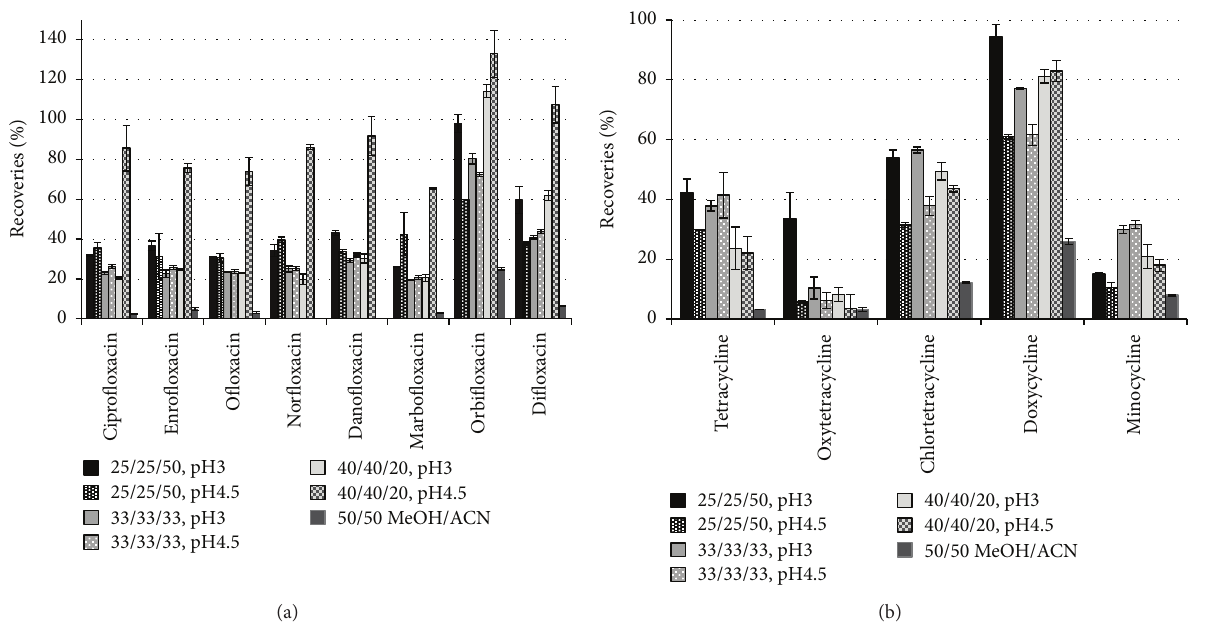
Figure 1: Recoveries obtained for (a) fluoroquinolones and (b) tetracyclines, with various compositions of PLE solvent (MeOH/ACN/0.2 M citric acid) and pH values.